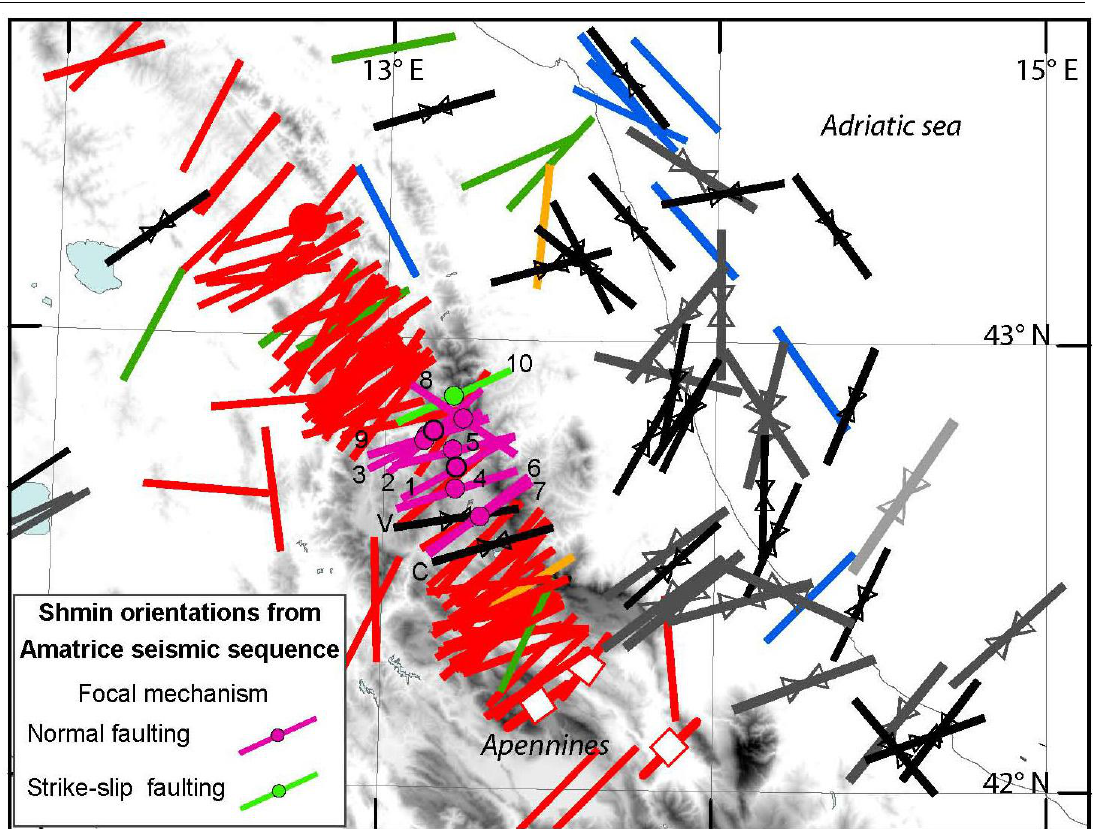
Figure 2. The 2016 Italian stress map and the new minimum horizontal stress (Shmin) orientations inferred from the available focal mechanisms of ten earthquakes with Mw≥4 [http://autorcmt.bo.ingv.it/quicks.html ] . Numbers as in Table 1. Bold circles are the event n. 1 and n. 2 of Figure 1 and Table 1. V and C stand for Varoni and Campotosto wells. See legend in Figure